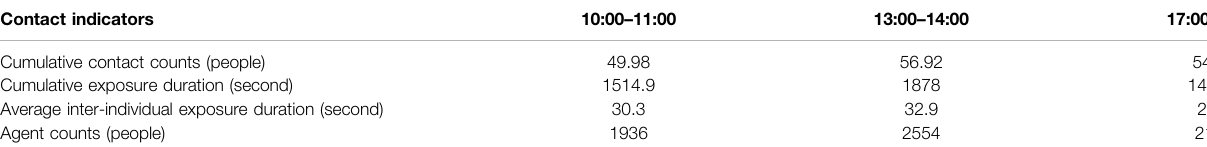
TABLE 2 | Estimation results of individual contact indicators in different time intervals. Contact indicators Cumulative contact counts (people)